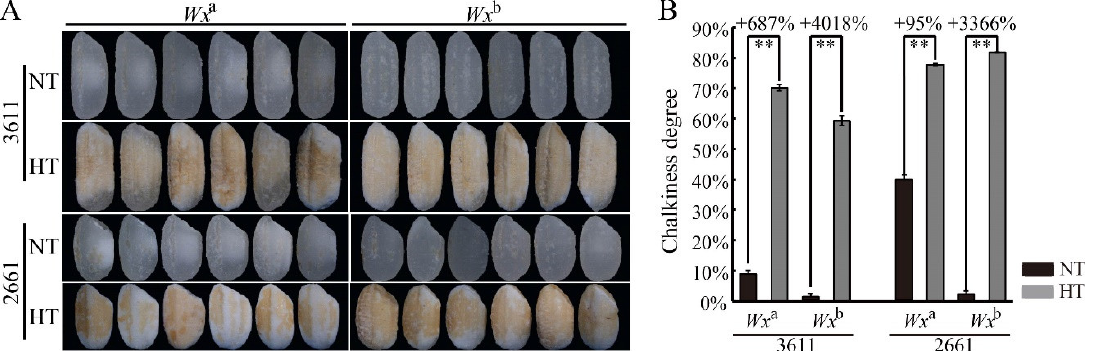
Figure 3. The influence of high temperature on the grain-filling degree of different Wx NILs. ( A ) Observation of mature grains from different Wx NILs treated by high temperature by photographing. ( B ) Chalkiness ratio of mature seeds from different Wx NILs treated by high temperature. “NT” stands for normal condition and “HT” stands for high-temperature condition. Double asterisks denote a highly significant difference using Student’s t -test ( p < 0.01). All significant-difference analyses were performed between the same samples at different temperatures.